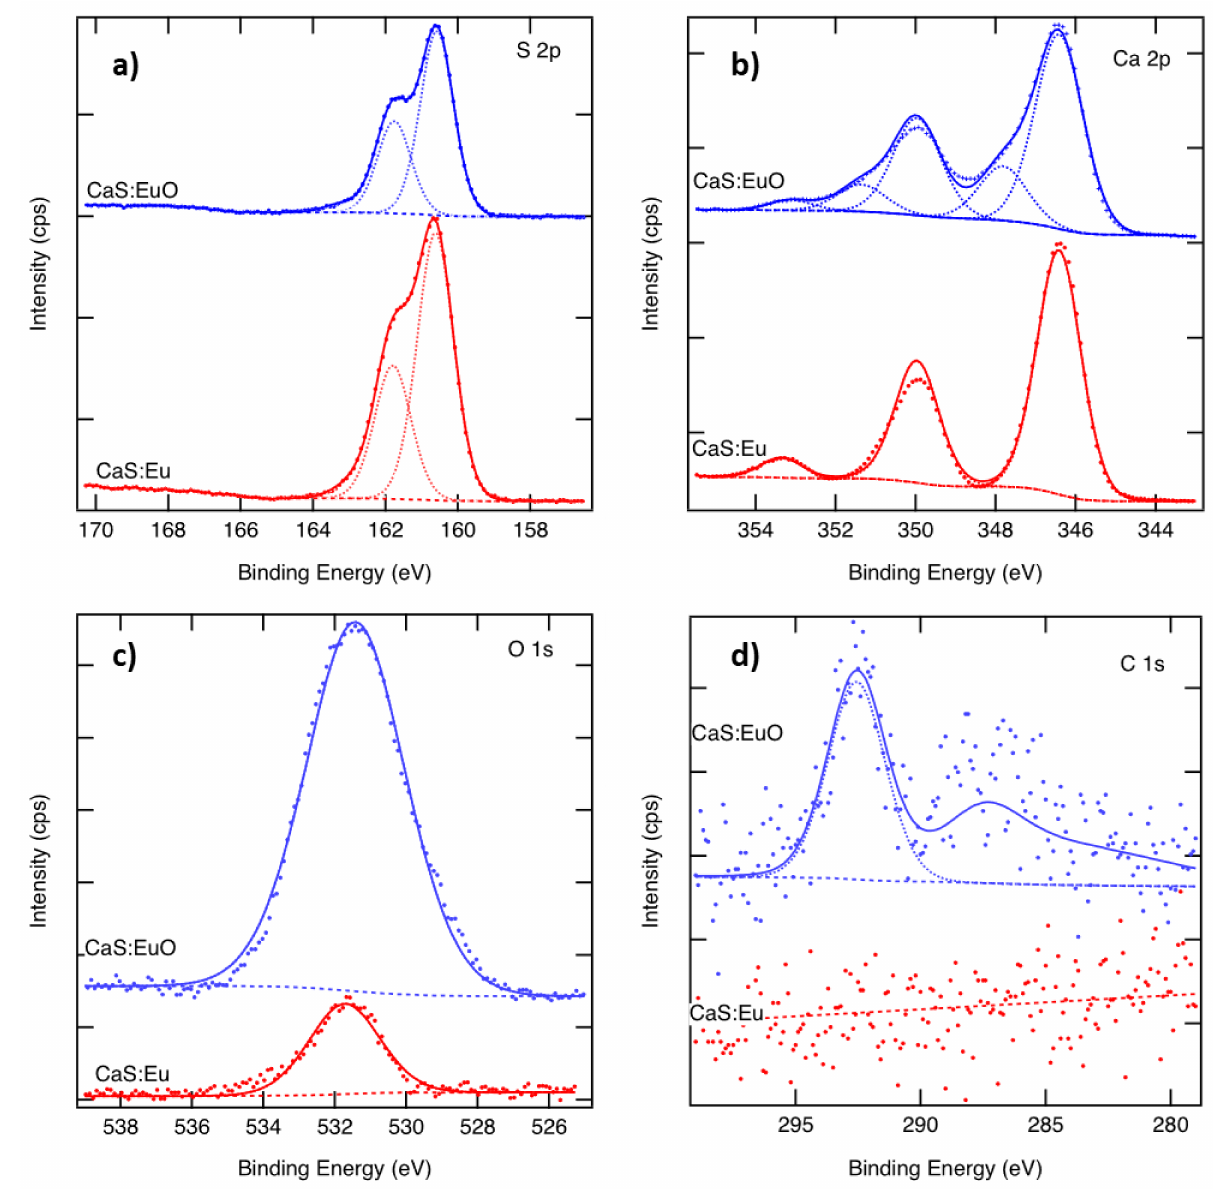
Figure 3. Measured and fitted ( a ) S 2p, ( b ) Ca 2p and ( c ) O 1s and ( d ) C 1s spectra of CaS:Eu and CaS:EuO samples. Figure 4 illustrate the Eu 3d core levels of CaS:Eu and CaS:EuO, respectively. Eu 3+ and Eu 2+ oxidation states can be identified in both samples if we accept binding energies 1134.4 eV and 1124.7 eV for the components [34]. However, the data are noisy despite of the long measurement time used. We can estimate that the Eu 3+ /Eu 2+ ratio is approximately 5/2 in CaS:Eu whereas in CaS:EuO it is close to